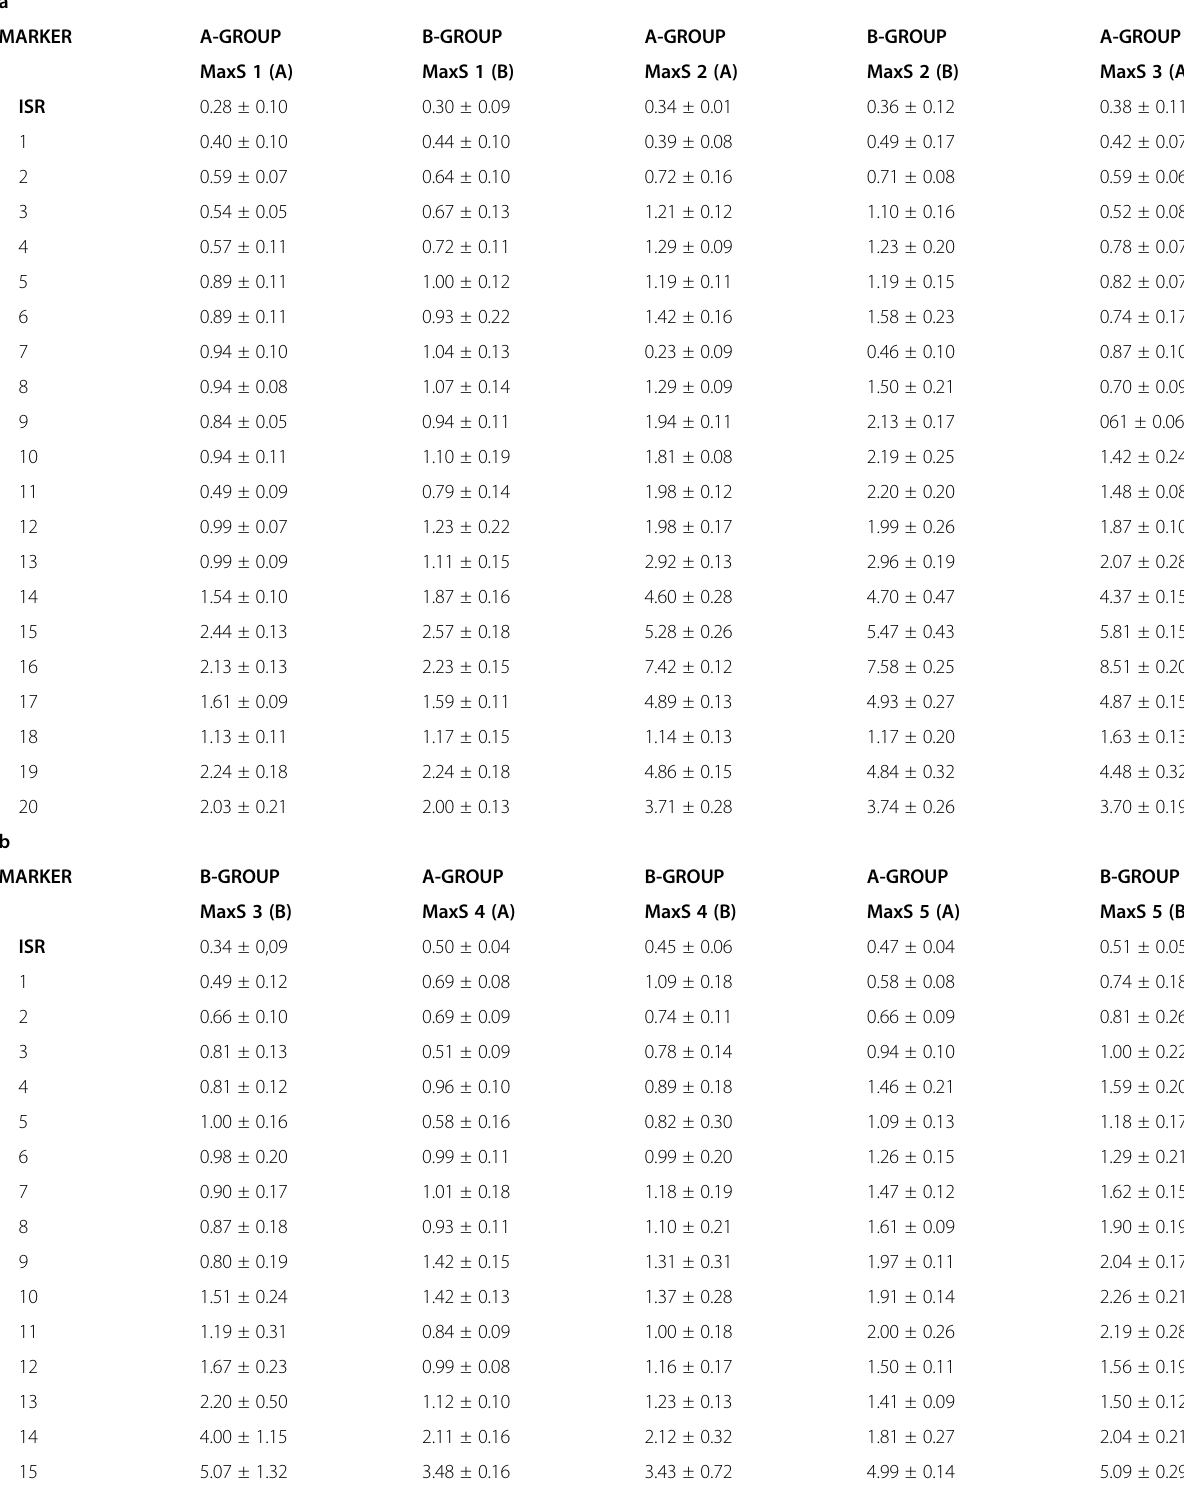
Table 3 Precision of two different splints (MaxS and VestS) measured at twenty bone marker points. Group A was